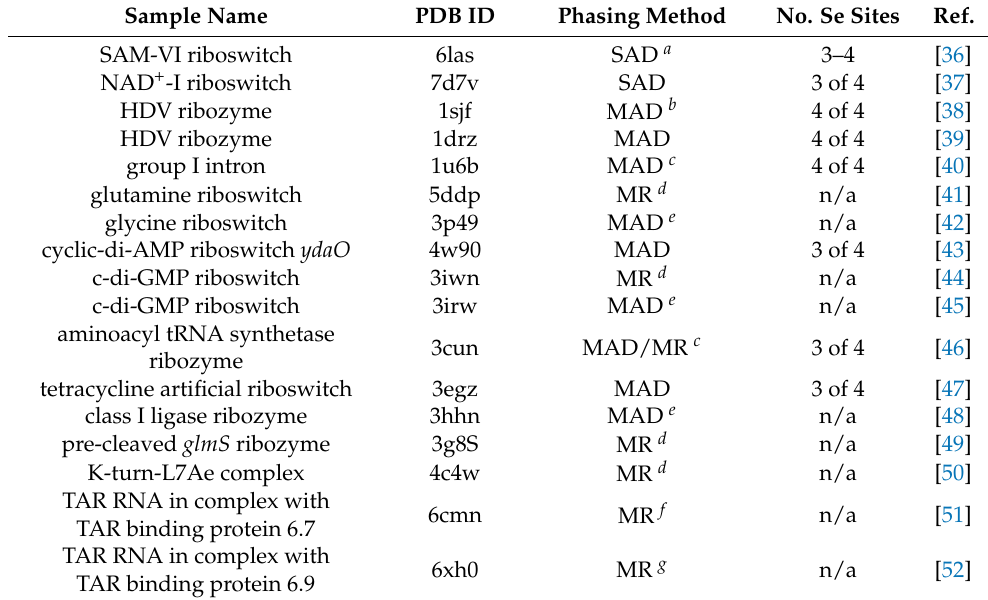
Table 1. Representative Structures in Complex with dmU1A or